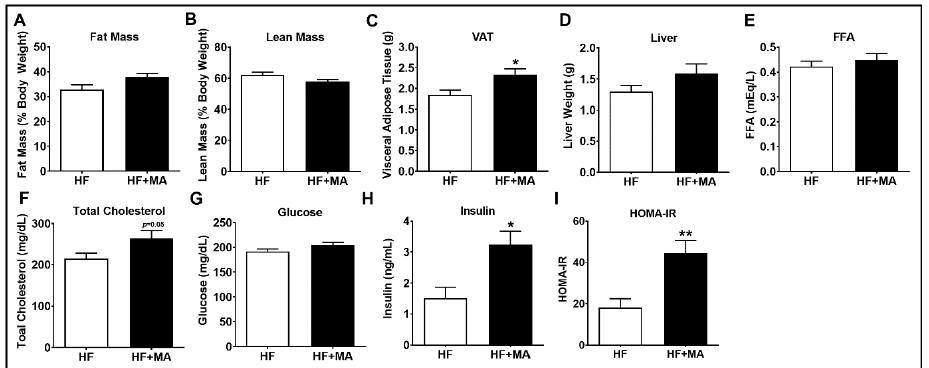
Figure 2. Effect of dietary myristic acid on metabolic variables. Total fat mass ( A ) and lean mass ( B ) were assessed in live mice using the EchoMRI body composition analyzer. VAT ( C ) and liver weights ( D ) were determined at sacrifice. Plasma-free fatty acids ( E ) and total cholesterol ( F ) were measured. Fasting blood glucose ( G ), plasma insulin ( H ), and HOMA-IR ( I ) were assessed. Values are expressed as mean ± SEM of 7–8 samples per group. * p < 0.05 and ** p < 0.01 vs. HF. HF, high fat;